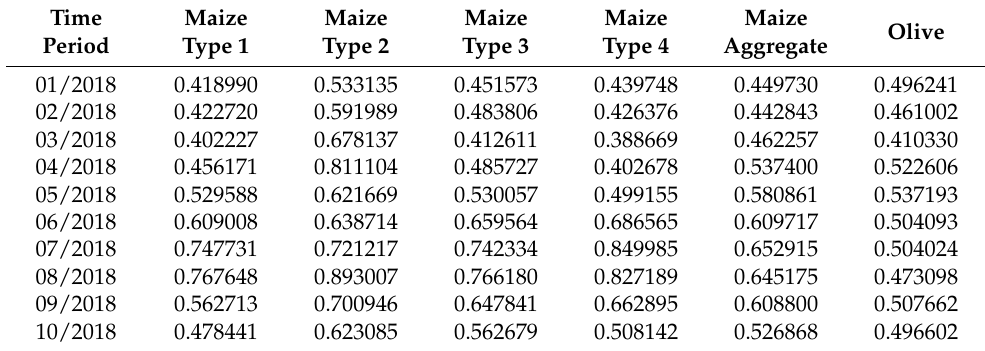
Figure 15. Forecast out of sample for the first ten months of 2018 for four types of maize crops, olive and aggregated maize. Table 1. Forecast for type 1–4 maize crops and olive crops from January 2018 to October